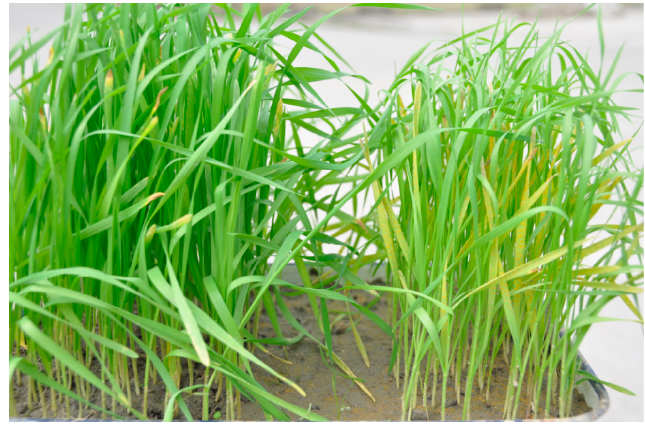
Figure 1. The seedlings of CH45 ( left ) and CH42 ( right ) inoculated by race No. 09-6-16-3.